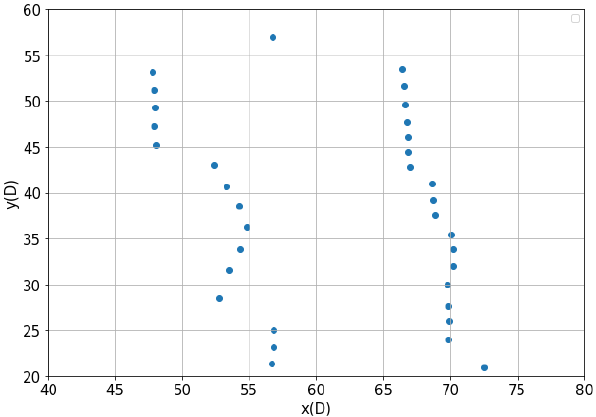
Figure A1. Map of a selected section of the observed wind farm discussed in Sect. 4.2. This plot show the inter-distance between turbine locations in the northing ( y ) and easting ( x ) directions. The distances shown on each axis are labeled relative to the average rotor diameter ( D ) of the turbines in the wind farm.